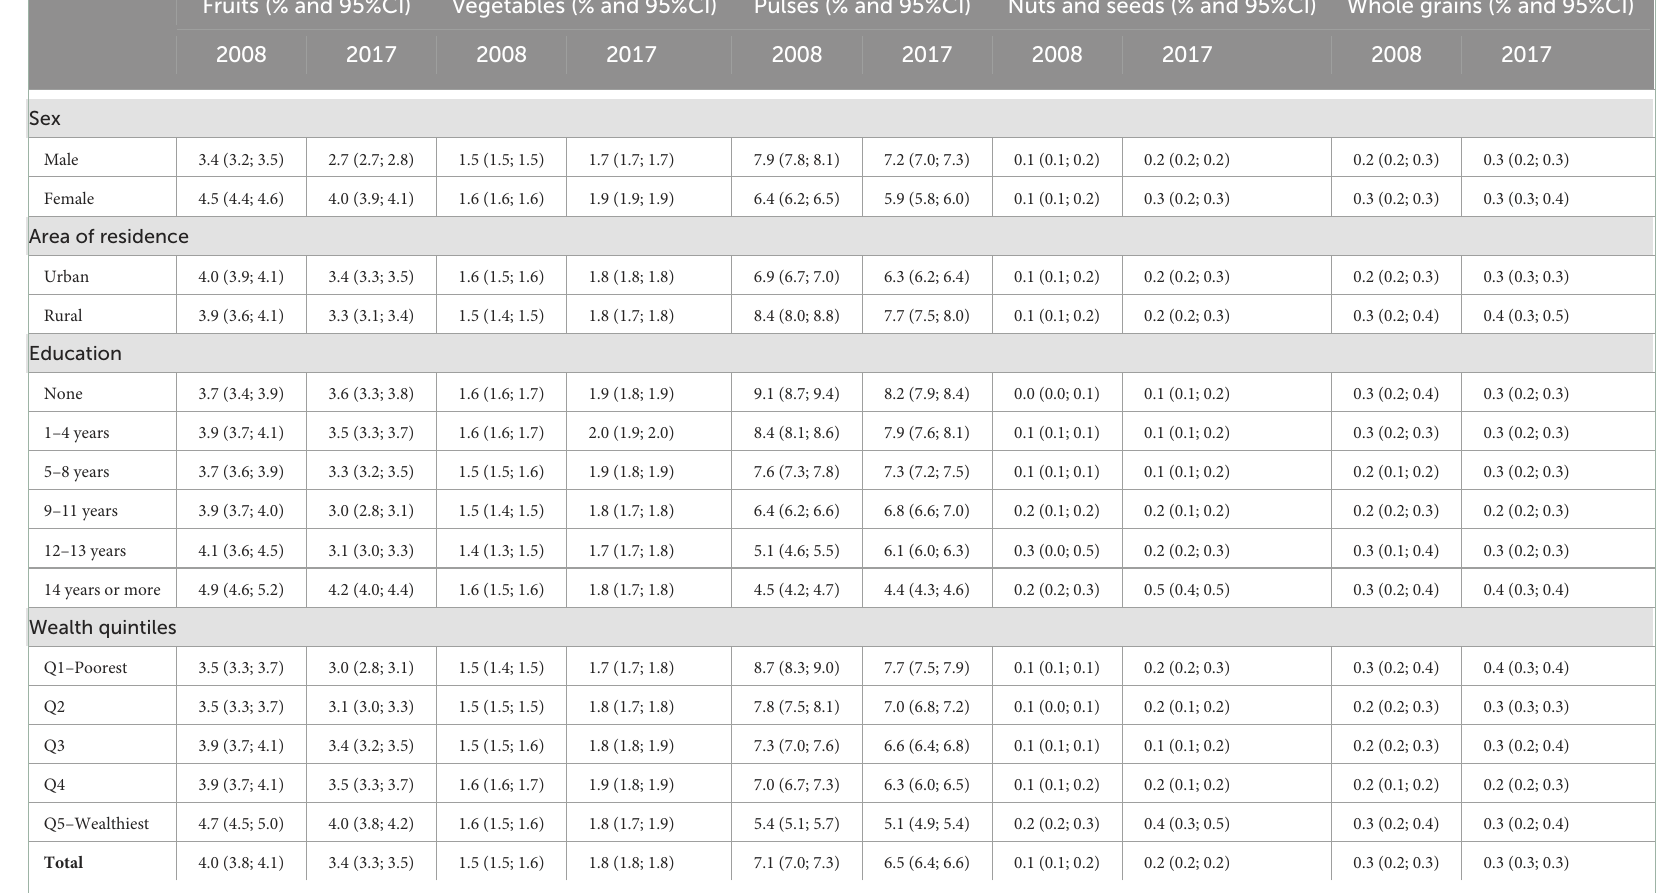
TABLE 2 Consumption of subgroups of the set of plant-based natural or minimally processed foods (as percentage of total energy intake) by sex, area of residence, education, and wealth quintiles in 2008 and 2017. Fruits (% and 95%CI) Vegetables (% and 95%CI) Pulses (% and 95%CI) Nuts and seeds (% and 95%CI) Whole grains (% and